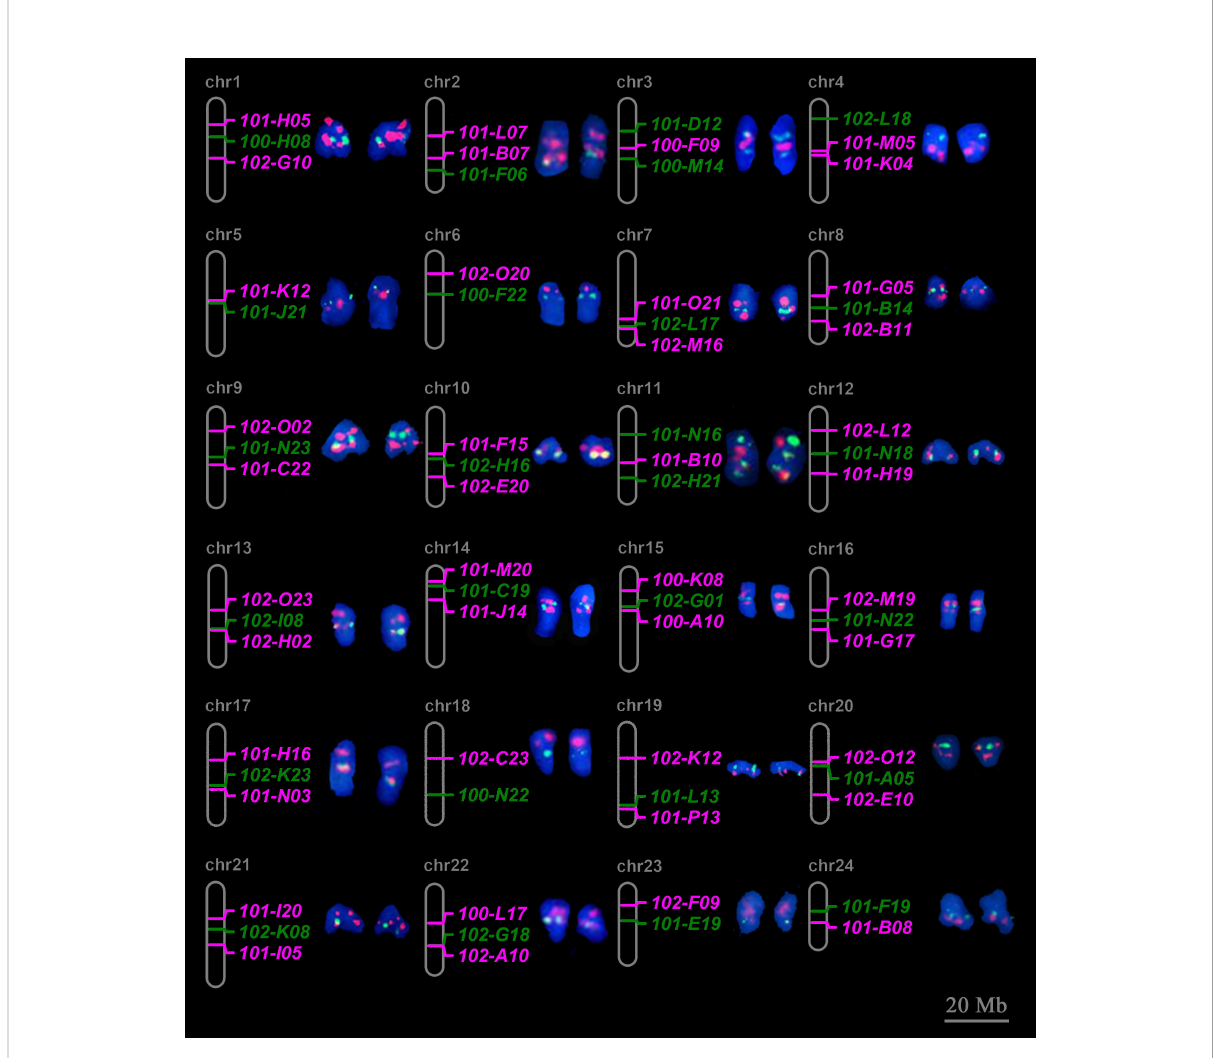
FIGURE 2 Twenty-four individual chromosomes of large yellow croaker with dual-color FISH signals derived from chromosome-speci fi c BAC clones. The expected chromosomal locations of BAC clones according to alignment of paired BAC end sequence to the reference genome of large yellow croaker are shown on the right side. The corresponding metaphases seen in Supplementary Figure 4. Red and green signals correspond to digoxigenin- and biotin- labeled probes. Scale bar represents 20 Mb for